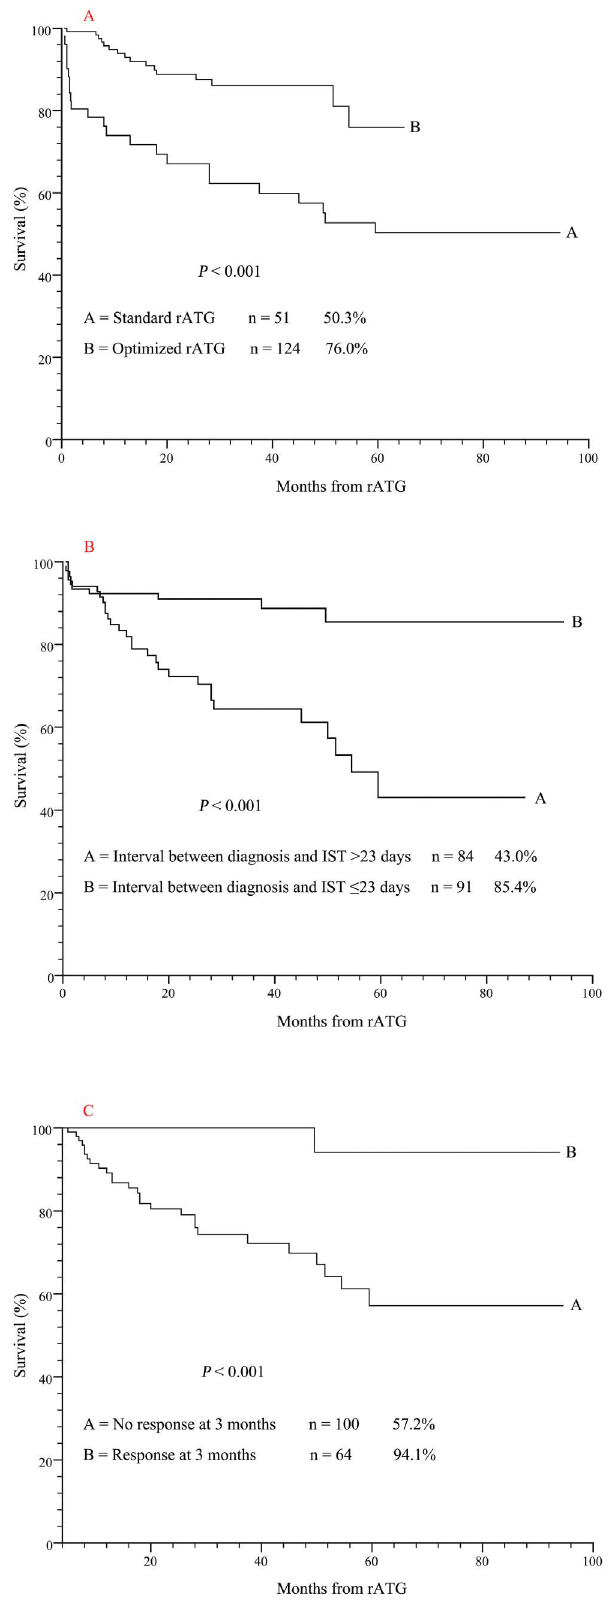
Figure 2. Kaplan-Meier curve of overall survival. A, The 5-year OS of patients received Optimized rATG was superior to that of patients received Standard rATG ( P , .001). B, Longer interval between diagnosis and IST ( . 23 days) predicted a worse 5-year OS ( P , .001). C, The patients with response at 3 months had significantly higher 5-year OS ( P ,